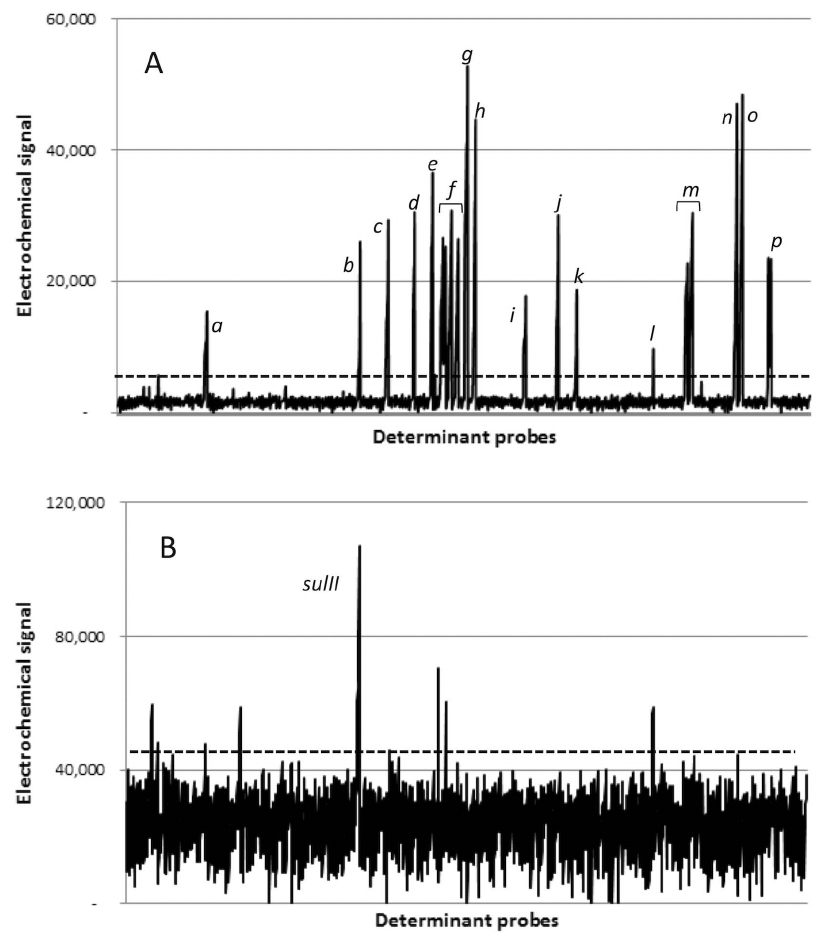
Figure 2. Electrochemical signals from MDR reference strain, A.baumannii BAA-1710 (A) and antibiotic sensitive reference strain, A. baumannii 17978 (B). Each data point represents one probe; data are sorted according to alleles represented by each probe. In each panel, the horizontal dotted line indicates the ‘‘probe threshold’’ used to determine whether probes were considered positive (mean of lowest 95% probes + 3 SD). For panel A, peaks correspond to the following alleles: a : tet(G) [9/9 probes positive]; b : cat4 [5/7 probes positive]; c : dfrA1 [9/9 probes positive]; d : catA1 [6/8 probes positive]; e : arr-3 [8/8 probes positive]; f : aph6/str(B) [8/10 probes positive], aph3 0 /str(A) [10/10 probes positive], aadA1b [10/10 probes positive], aadB [10/10 probes positive]; g : qacE D 1 [10/10 probes positive]; h : aadA2 [2/9 probes positive - allele deemed negative], aadA1 [7/7 probes positive]; i : bla VEB [9/9 probes positive]; j : bla OXA-10 [7/7 probes positive]; k : dfrA10 [8/10 probes positive]; l : bla PSE-1/CARB [2/10 probes positive – allele deemed negative]; m : aacC1 [9/9 probes positive], aphA1 [10/10 probes positive]; n : ant(2 9 )-Ia [10/10 probes positive]; o : sulI [10/10 probes positive]; p : tet(A) [9/9 probes positive]. For panel B, the sulII allele (peak indicated) was deemed positive with 7/7 probes positive; other alleles had one or two positive probes, but were deemed